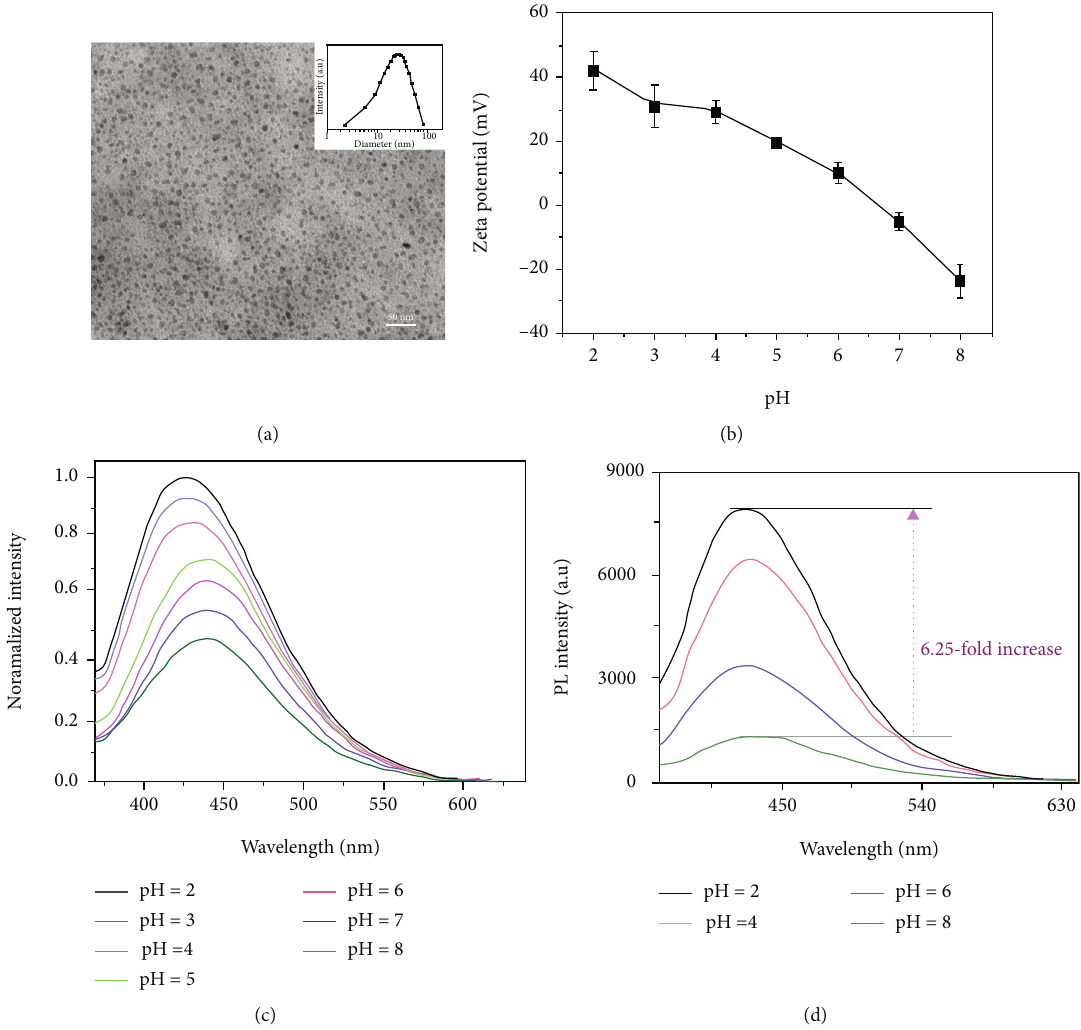
Figure 5: (a) TEM image of the micelles at pH = 2 . Inset: size distributions of aqueous solutions of chitosan and TPE-(N-COOH) at pH = 2 . (b) The zeta potential of micelles at di ff erent pH values. pH-dependence fl uorescence emission spectra recorded for the aqueous solution of (c) WCS/TPE-(N-COOH) micelles and (d) TPE-(N-COOH) with pH decreasing from 8 to 2, λ ex = 345 nm, 25 ° C. The molar 4 4 concentration was fi xed at 1.0g/L in all ratio of [NH 3+ ]/[COO - ] was 1.0, and the TPE-(N-COOH) 4